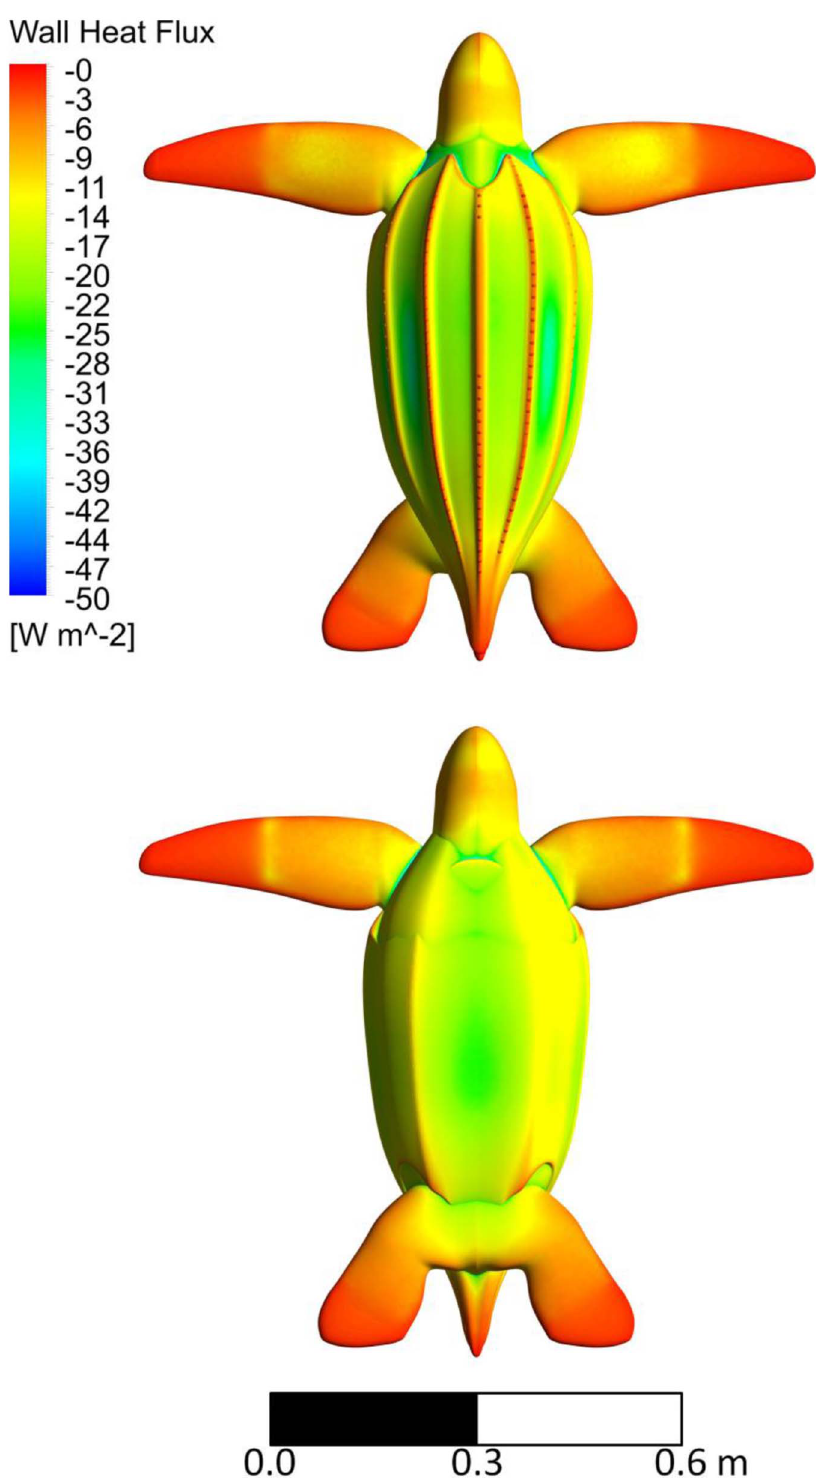
Figure 12. The heat flux contours on the internal conduction model of the juvenile turtle. doi:10.1371/journal.pone.0110701.g012 Table 1 gives average flipper and body heat transfer coeffi- cients, power and force for the juvenile simulation. The juvenile power profiles show a reasonable output with areas of positive